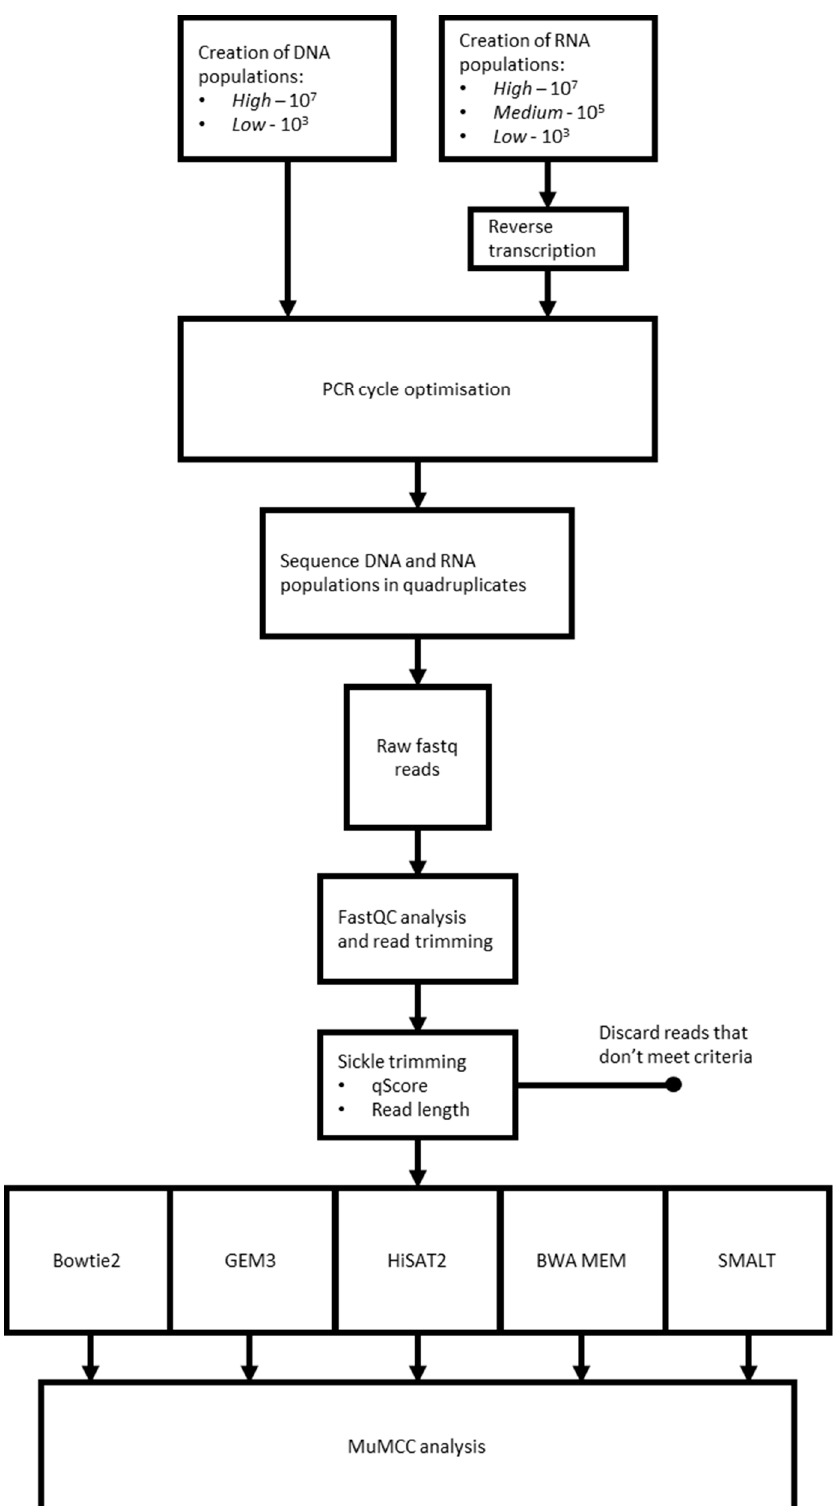
Figure 1. An overview of the high-throughput sequencing (HTS) pipelines evaluated in this study. Each pipeline comprised different combinations of laboratory and computational approaches.